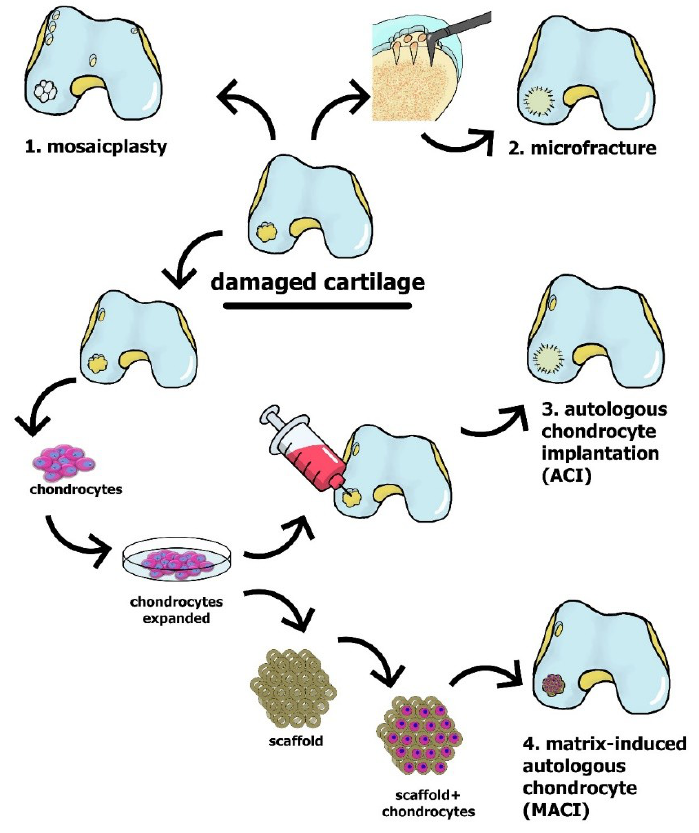
Figure 3. Illustration of the clinically approved approaches to restoration of cartilage tissue.